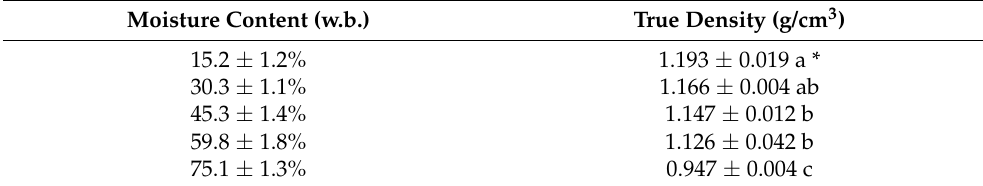
Table 1. True densities (mean ± SD over three replicates) of wolfberries at five moisture contents. Moisture Content (w.b.)